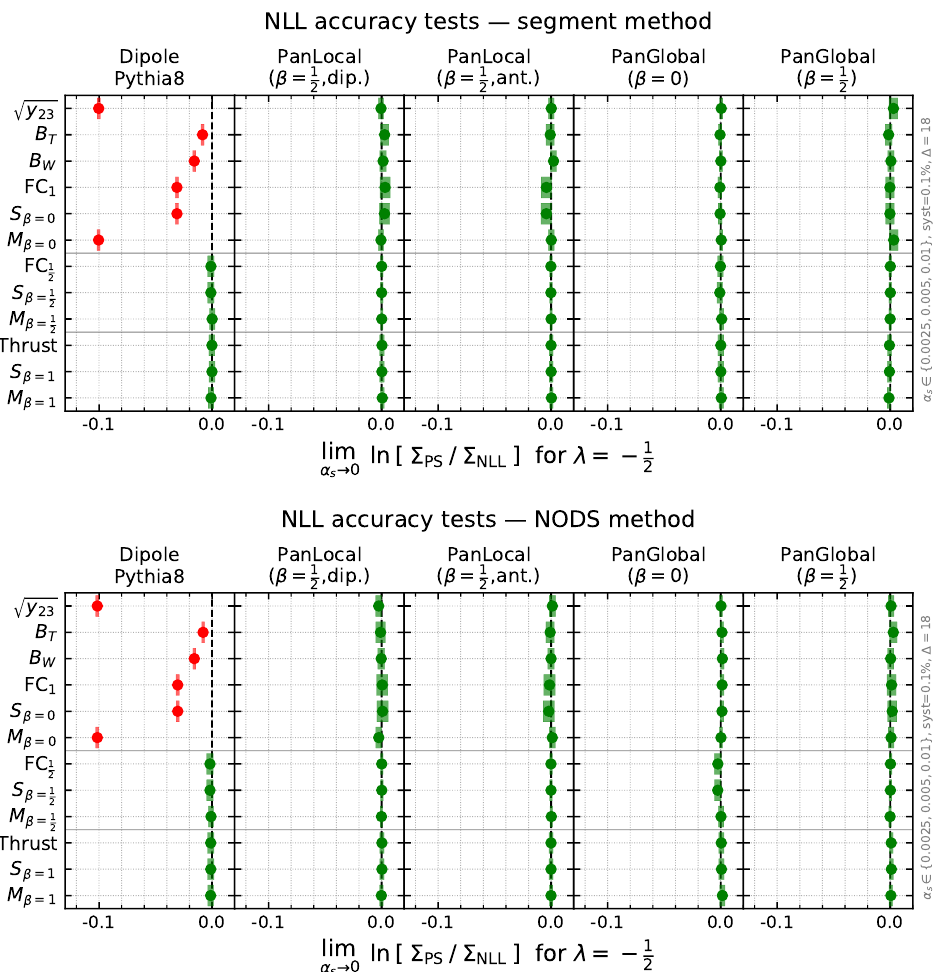
Figure 11. NLL global event-shape tests of the segment and NODS colour schemes, showing NLL agreement for β = 1 / 2 PanScales showers and for the β = 0 PanGlobal shower. In contrast to the NLL-LC tests of ref. [12], the Pythia 8 β 0 results here are coloured green rather than amber, obs > because our colour code does not incorporate the information about failure of exponentiation in fixed-order tests, tests that we have not explicitly repeated for this